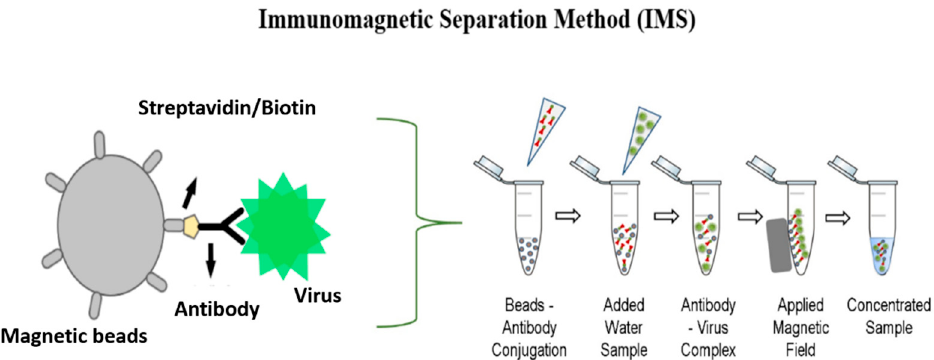
Figure 1. Magnetic bead surface functionalization with antibodies and immunomagnetic separation (IMS) procedure.